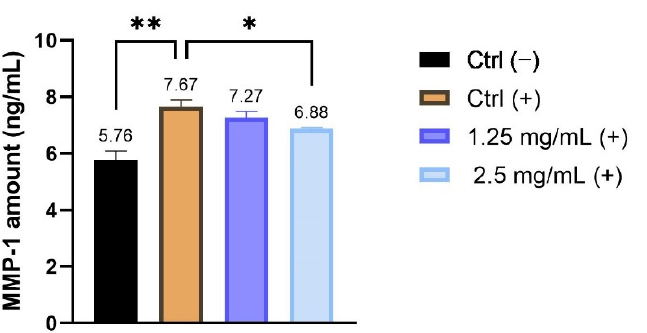
Figure 4. Quantitative analysis of MMP-1 levels (ng/mL) after treatment with the cosmetic cream at the concentrations of 1.25 and 2.5 mg/mL. Ctrl ( − ): untreated cells; UVB (+): irradiated cells. * p values ≤ 0.05 and ** p values ≤ 0.01 were considered to be statistically significant compared with irradiated cells ( n = 2; replicates = 2).